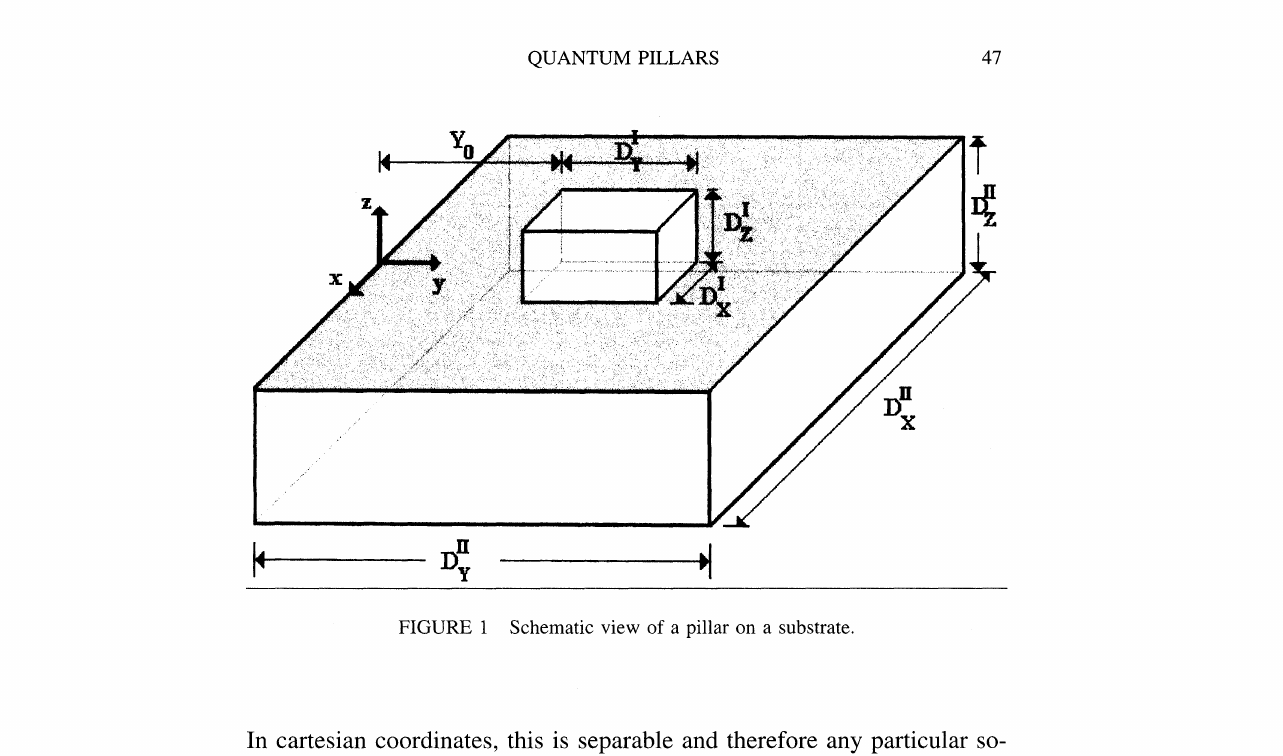
FIGURE Schematic view of a pillar on a